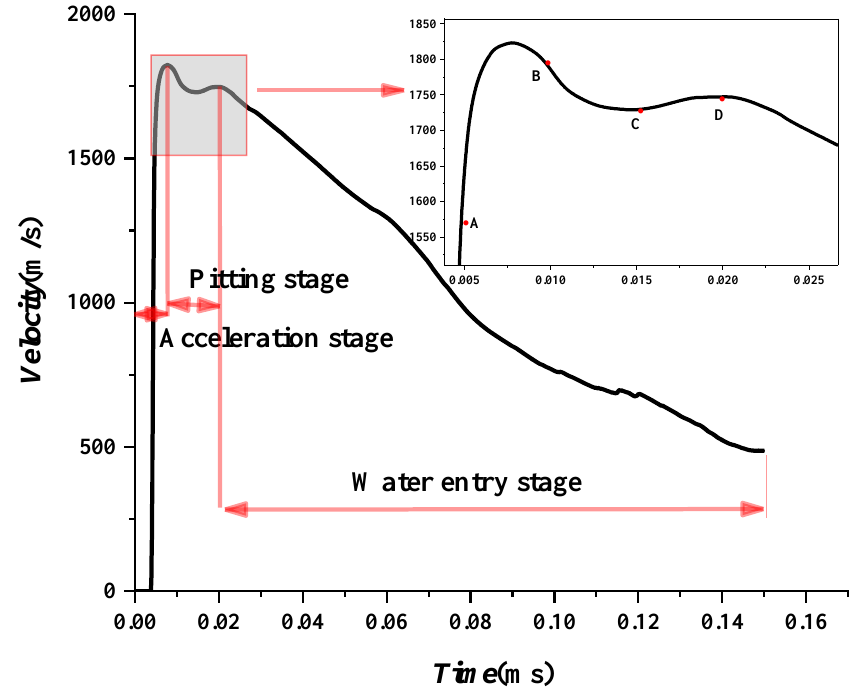
Figure 17. Evolution of the projectile entering water from air.